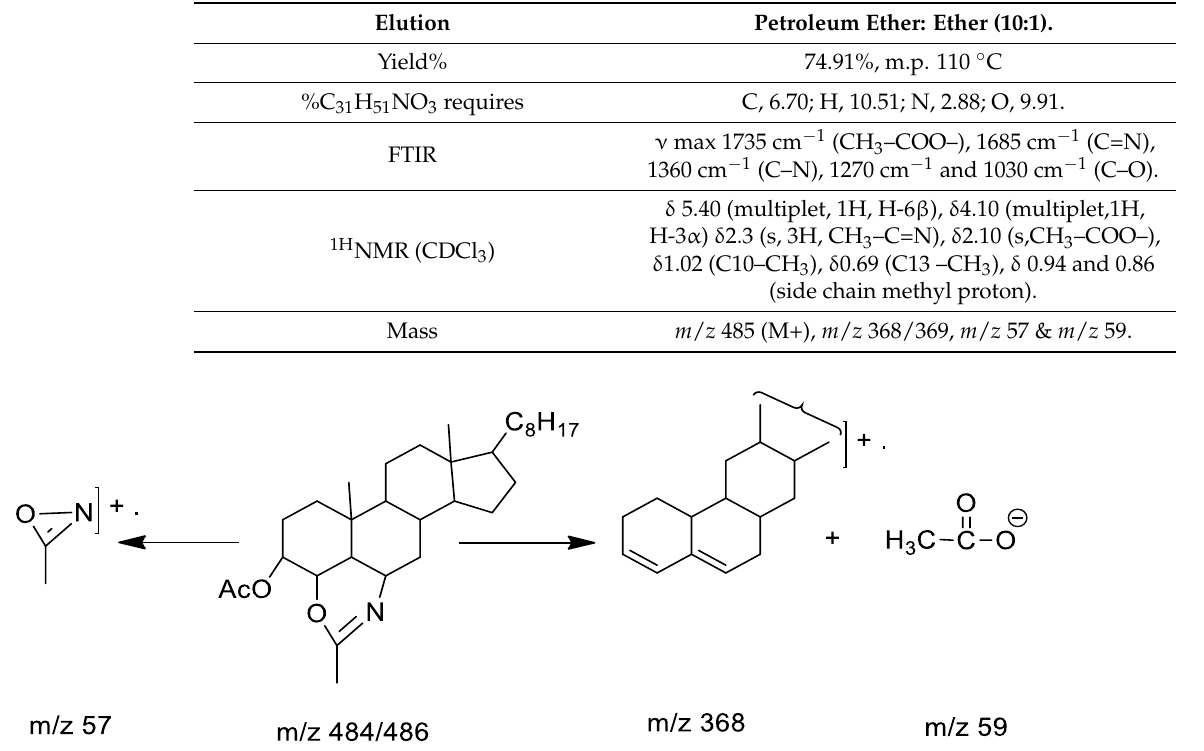
Table 2. FTIR, 1HNMR, and mass analyses of-acetoxy- 5α -cholestano- 2′ -methyl-2-oxazoline ( VI ).